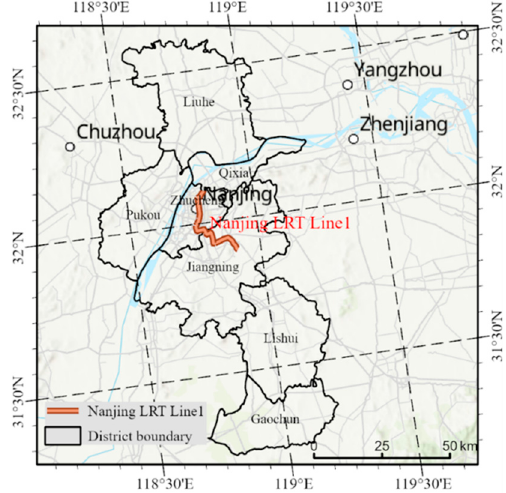
Figure 1. The city of Nanjing and Nanjing LRT Line 1. As shown in Figure 2, the urban LU data with 30 m spatial resolution in 1995, 2000, and 2005 are utilized in this study. This dataset was published by the Geographical Information Monitoring Cloud Platform (Available online: http://www.dsac.cn/, accessed on 3 March 2021), generated by manual interpretation from Landsat TM/ETM+/OLI image. The LU data includes six LU types: farmland, forest, meadow, water, construction, and unused. The overall classification accuracy of the farmland and construction is higher than 85%, while it is higher than 75% for the other LU